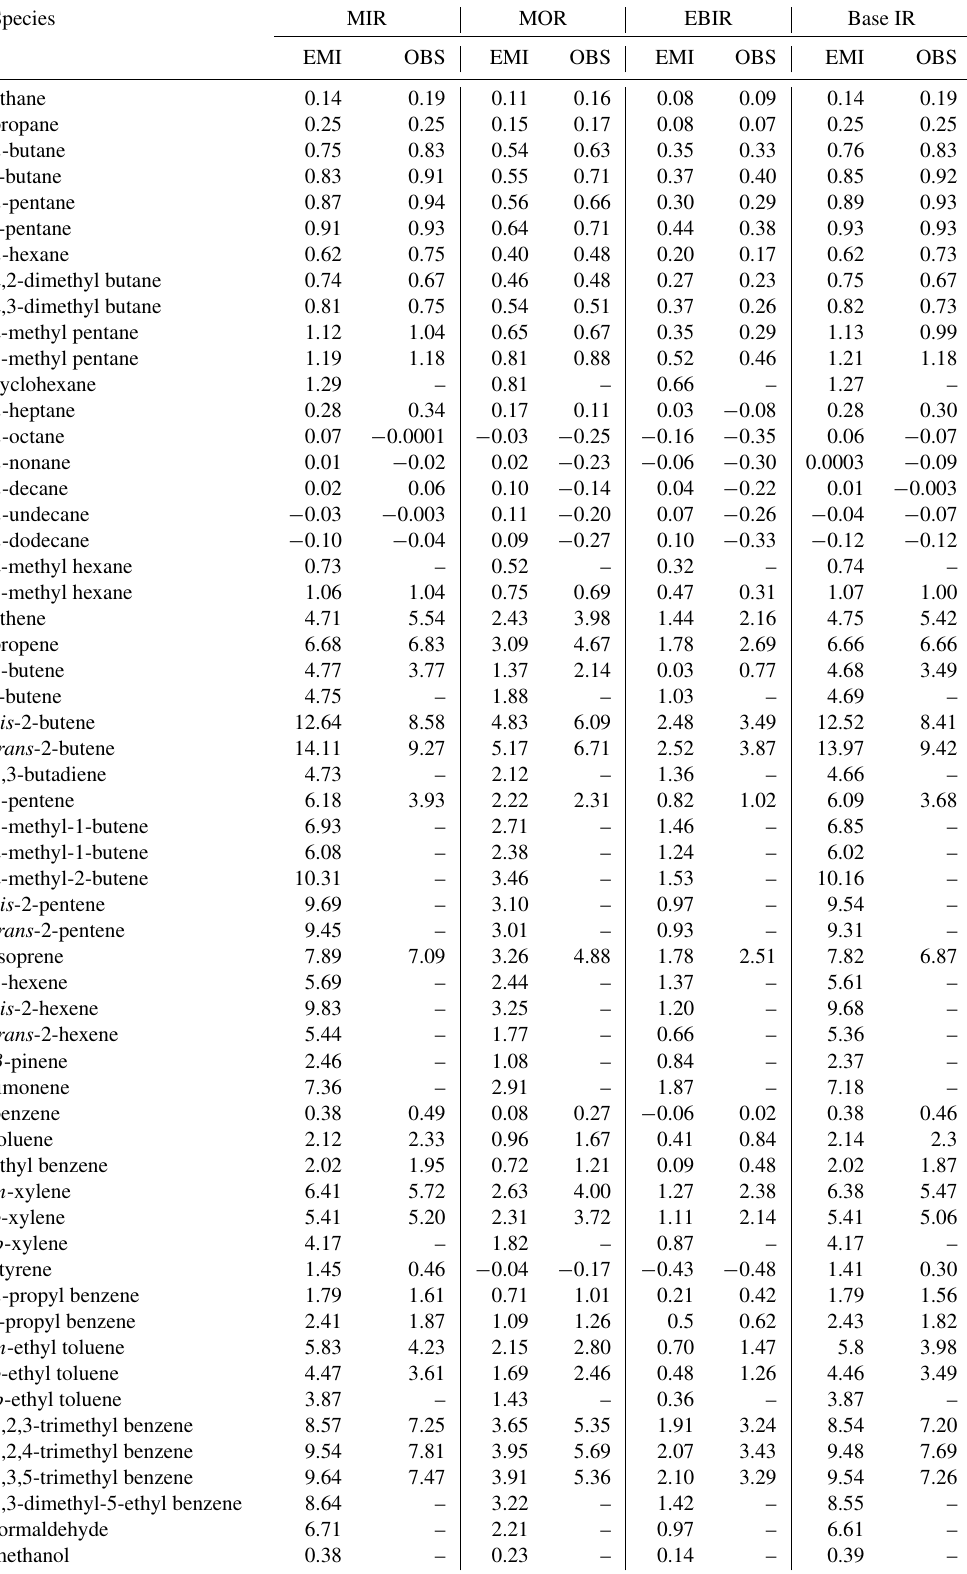
Table 1. Tabulation of IR (gO 3 / gVOC) for VOCs under three specified NO x conditions and base NO x conditions. “EMI” represents emission-based inputs, while “OBS” represents observation-based